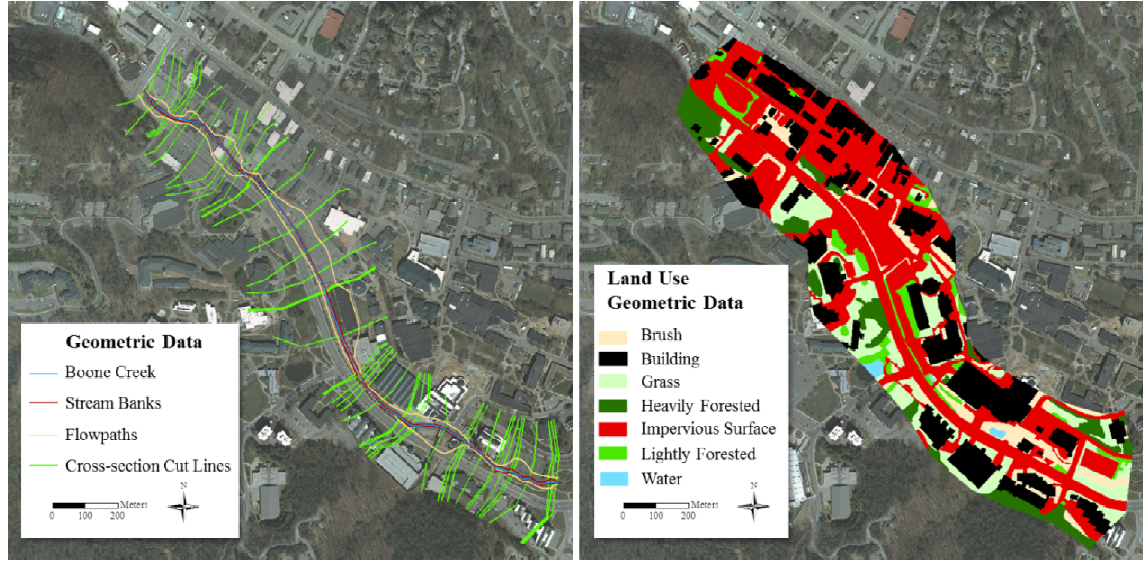
Figure 5. Geometric data consisting of stream centerline, stream banks, cross-section cut lines, flow-paths, blocked obstructions, and land use polygons were digitized from 2010 6-inch orthoimagery [44] for the flood inundation